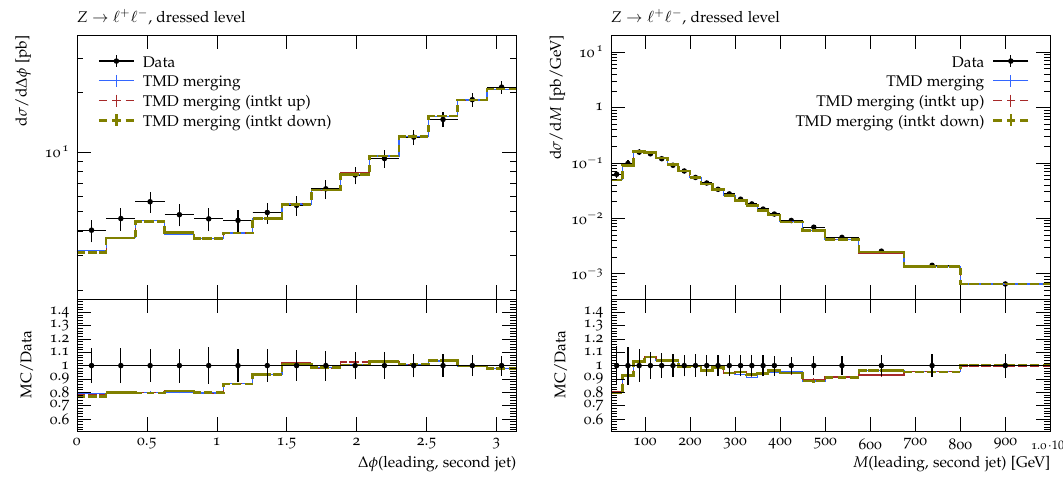
Figure 31 . Di-jet azimuthal separation (left) and di-jet mass (right) distributions for Z + ≥ 2 jets events: intrinsic- k sensitivity. T